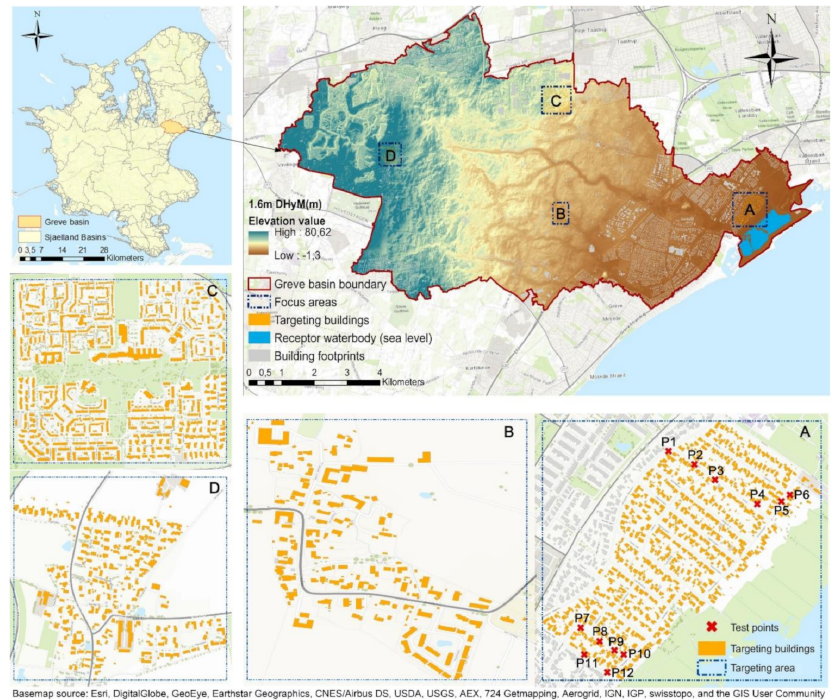
Figure 6. Case study area: Basin divisions for Zealand and location of the Greve basin (upper left); the hydro-conditioned elevation model (1.6 m resolution) covering the Greve basin (upper right). Map A, B, C and D show four selected focus areas and their target objects (buildings) that were hit by the extreme rainfall event on 2 July 2011. Areas marked with a red × represent locations where water depths and velocity hydrographs are extracted (L-shaped in the northeast, F-shaped in the